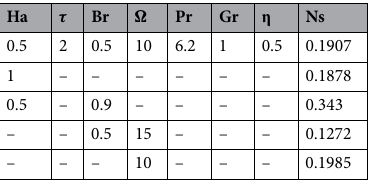
Table 4. Finite difference results for entropy generation.